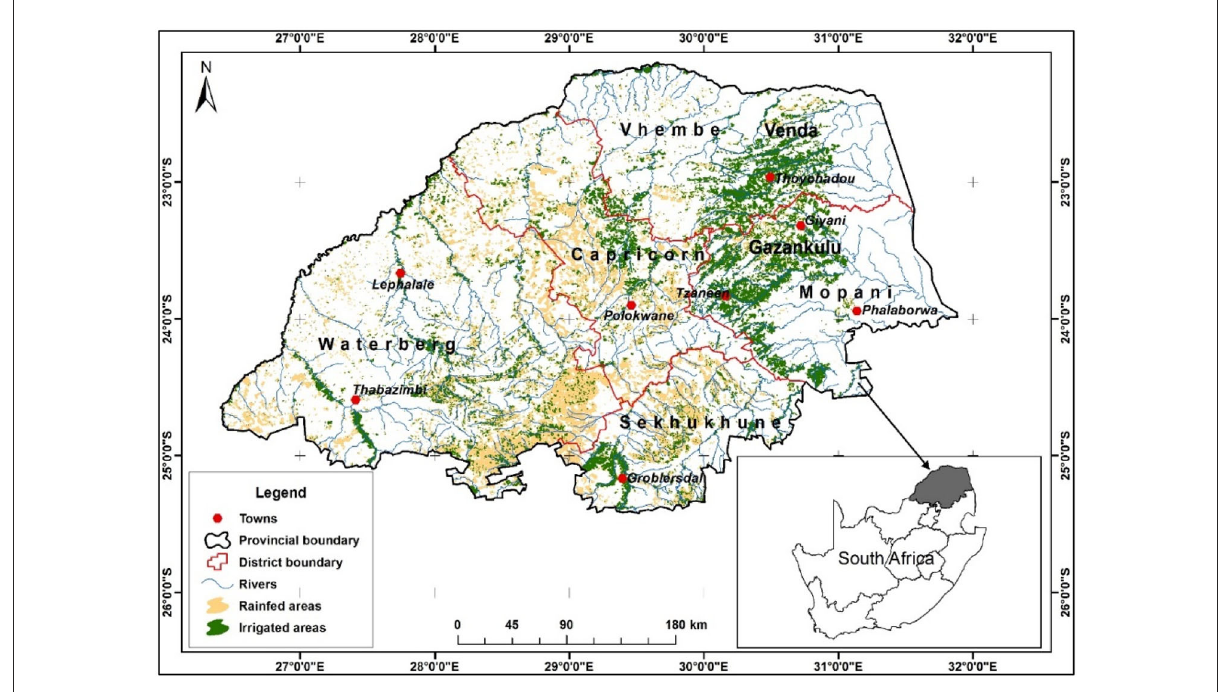
FIGURE2 Location map of Limpopo Province showing the distribution of agricultural